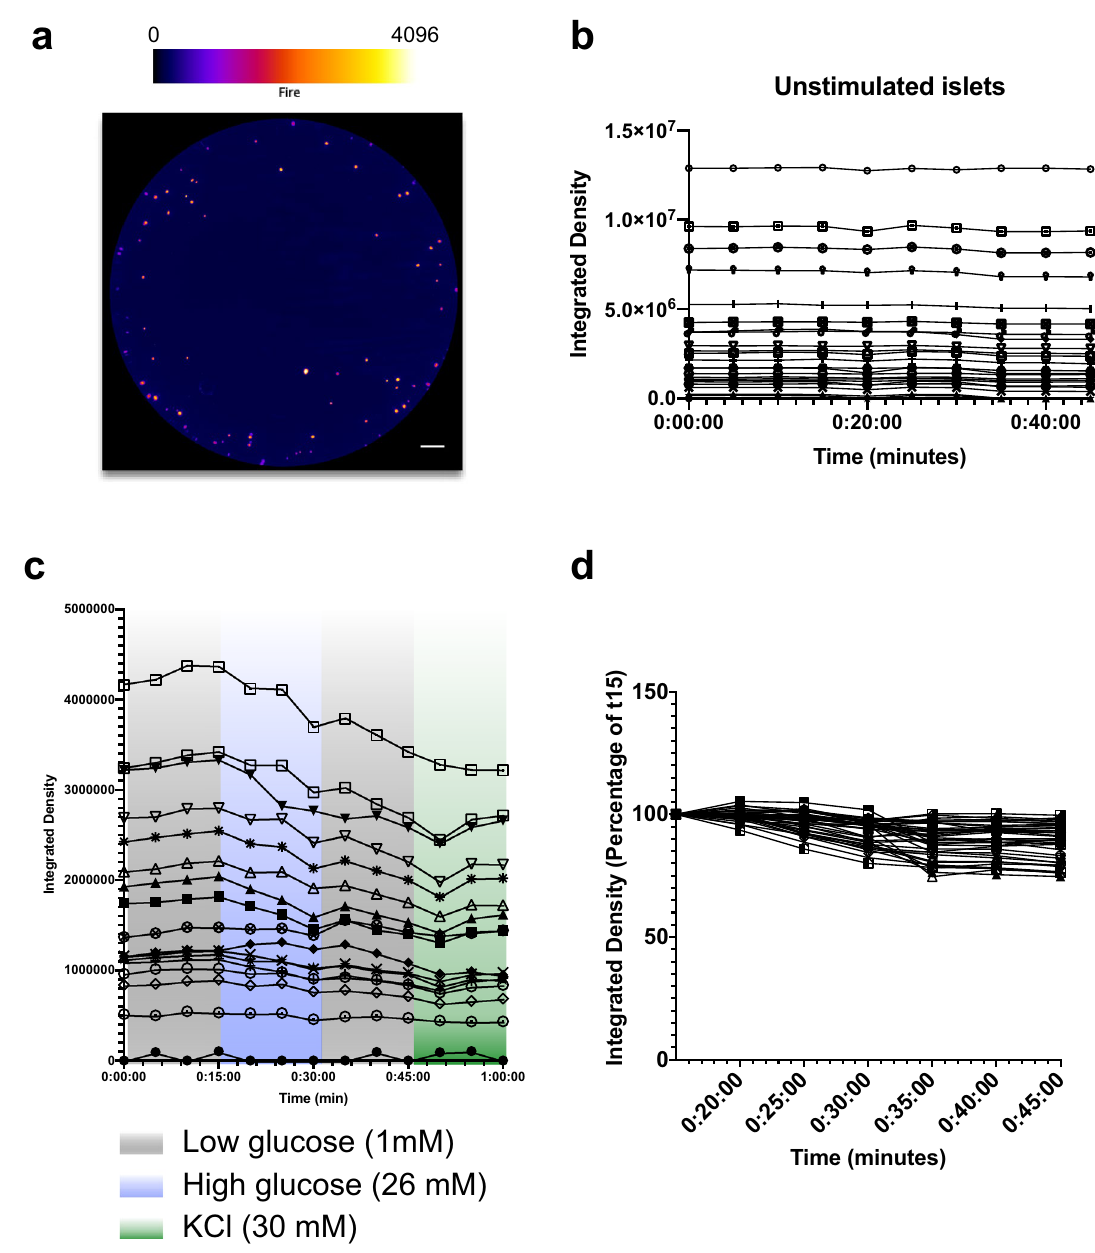
Figure 3. CpepSfGFP profiles in islets in culture. ( a ) CpepSfGFP islets in culture in collagen with intensity- based “Fire” pseudocoloring (scale on top). ( b ) Integrated density of the unstimulated individual CpepSfGFP islets over 45 min of culture. ( c ) Integrated density of CpepSfGFP individual islets in culture during a GSIS in low (1 mM) glucose, then high (26 mM) glucose, low glucose again and finally KCl (30 mM). ( c ) Individual islets from figure ( c ) represented as a percentage change from t15 (time at which the islets are stimulated with glucose). Scale bar 500